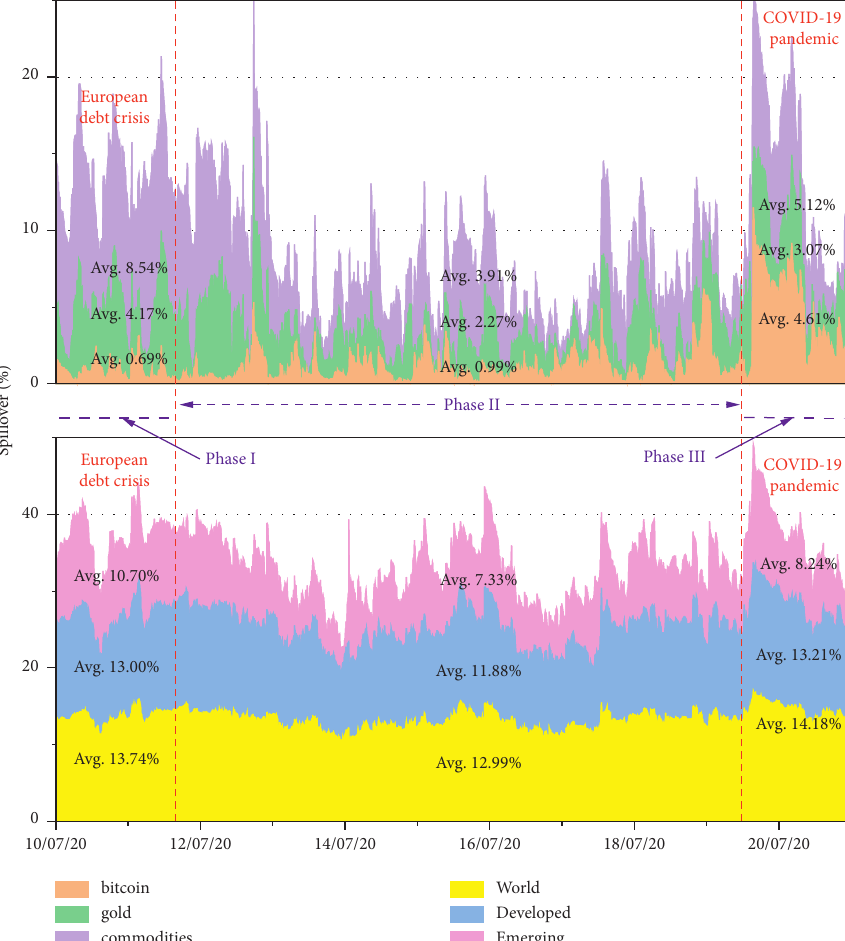
Figure 3: Dynamic total directional spillover to others for TVP-VAR. The different color areas define the accumulation of total directional spillover to other markets. The total directional spillover to others of returns plotted here is computed by equation (10), which is defined as the difference in total directional connectedness to others. All abbreviations are as follows: bitcoin, gold, and commodities indices (commodities); the world stock index (world); the developed stock index (developed); and the emerging stock index (emerging). The sample period for returns is from July 20, 2020, to June 23,